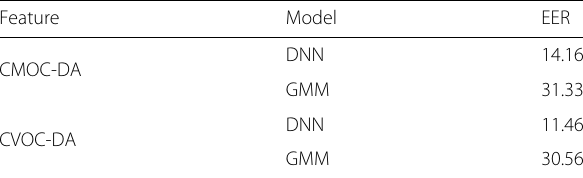
Table 6 Comparison with GMM on ASVspoof 2017 V2 evaluation set in terms of EER